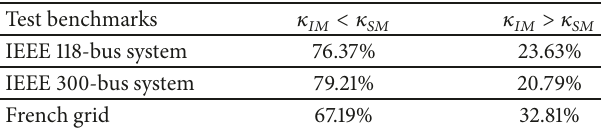
Table 5: Comparisons of the metrics by the rate of load